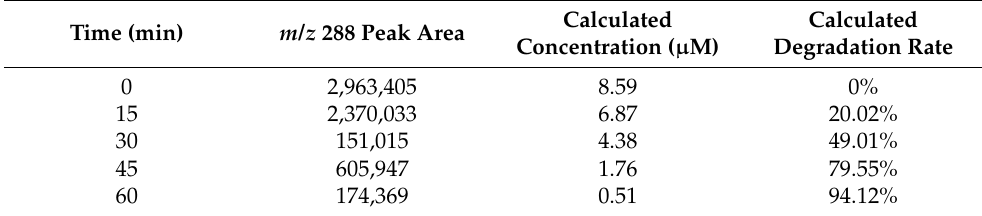
Table 2. HPLC-MS photodegradation results of AR 14 by ZnO NWs under UV light. Time